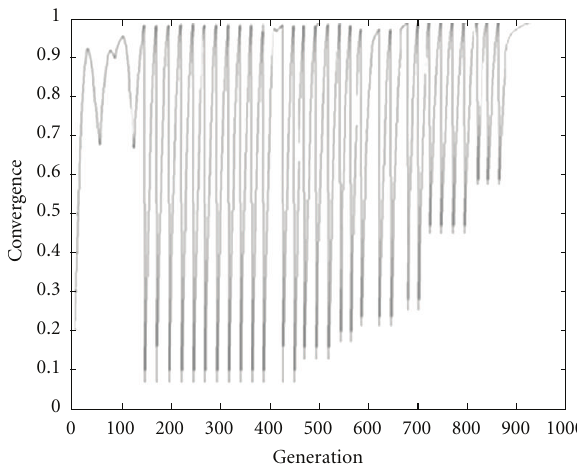
Figure 13: Convergence rate of MSB-ABC in the first step. Figure 14: Convergence rate of MSB-ABC in the second step.